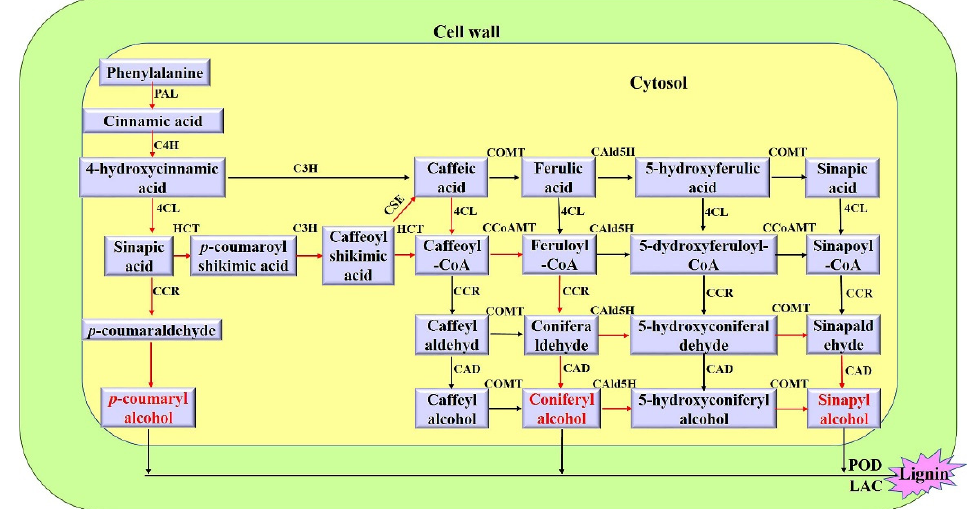
Figure 1. The general lignin biosynthesis pathway [6,7]. The red arrows indicate the main metabolic flux. PAL, phenylalanine ammonia-lyase; C4H, cinnamate 4-hydroxylase; C3H, p-coumaroyl-CoA 3-hydroxylase; 4CL, p-coumarate CoA ligase; HCT, hydroxycinnamoyltransferase; CSE, caffeoyl shikimate esterase; CCoAOMT, caffeoyl-CoA O-methyltransferase; CCR, cinnamoyl-CoA reductase; CAld5H, coniferaldehyde 5-hydroxylase; COMT, caffeic acid 3-O-methyltransferase; CAD, cinnamyl alcohol dehydrogenase; POD, peroxidase; LAC, laccase. p-coumaryl alcohol (H monolignol), coniferyl alcohol (G monolignol) and sinapyl alcohol (S monolignol) are marked in red.